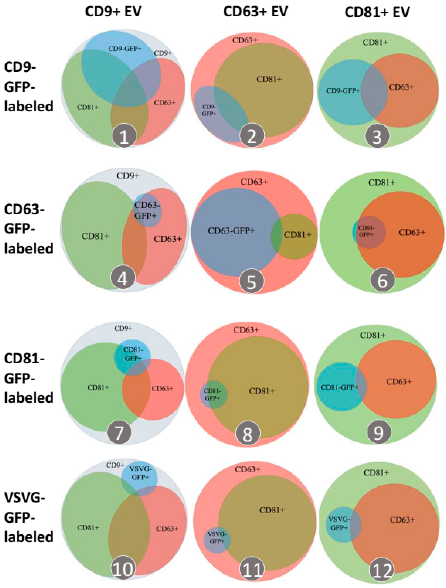
Figure 4. Transmembrane scaffolds incorporate into distinct EV subtypes. Venn diagrams summarize percentages of labeled EVs in each distinctive subpopulation of EVs. EVs captured by anti-CD9, anti-CD63, or anti-CD81 antibodies are characterized as CD81 + (green outer circle), CD63 + (red outer circle), or CD9 + (grey outer circle) subpopulations, respectively (columns). The percentage of EVs modified by different transmembrane scaffolds, including CD9-GFP-, CD63-GFP-, CD81-GFP, or VSVG-GFP, is represented by the blue inner circle. The surface marker profiles of CD63 and CD81 determined by fluorescein-labeled anti-CD63 and anti-CD81 antibodies were represented by the smaller red and green inner circles/ellipses, respectively. The size of all circles and ellipses was pro- portional to their percentages. Table 1. Engineering efficiency with different scaffolds. CD9+ EVs